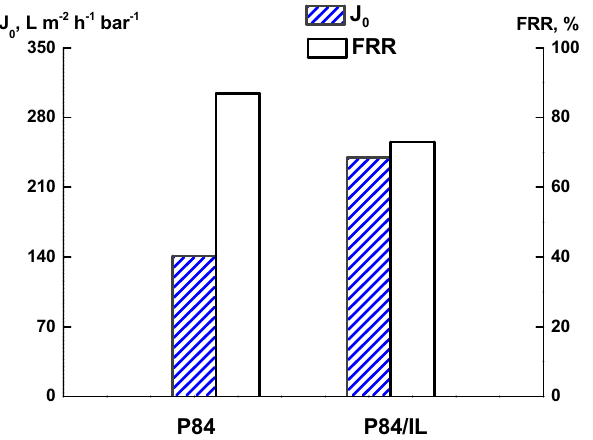
Figure 9. The pure water flux (J 0 ) and the flux recovery ratio (FRR) for the P84 and P84/IL membranes.